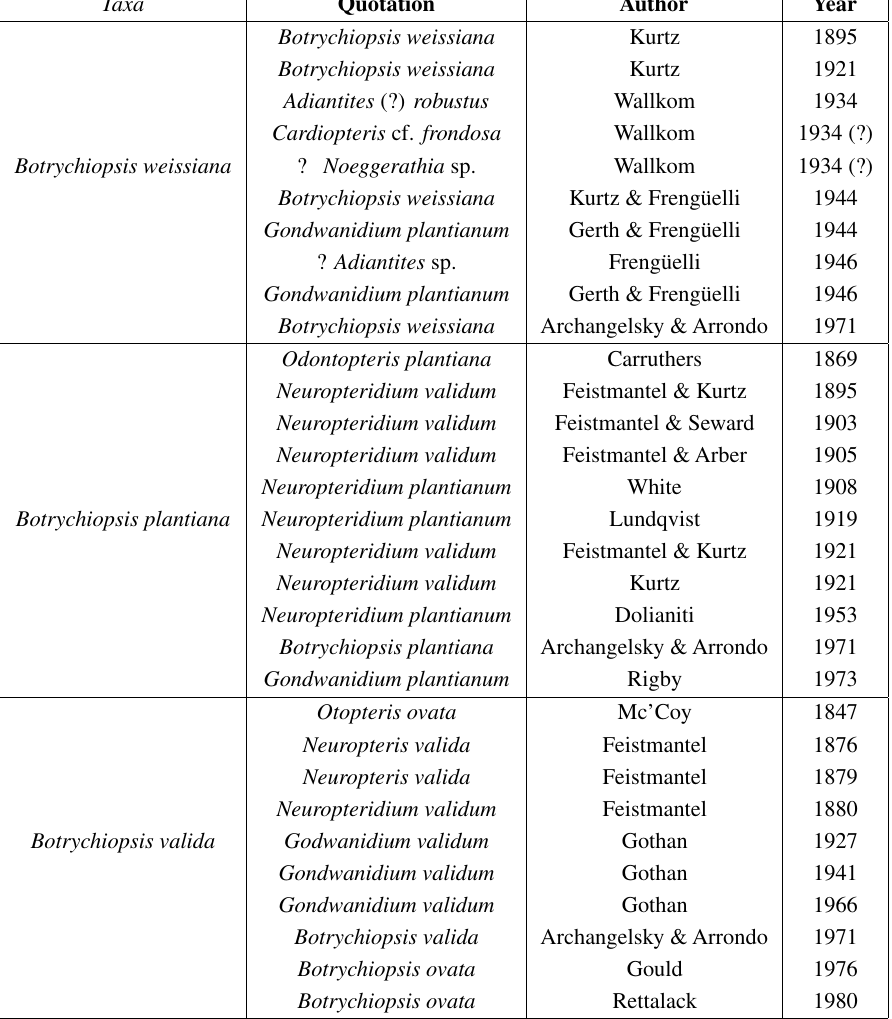
Fig. 1 – Current Botrychiopsis genus